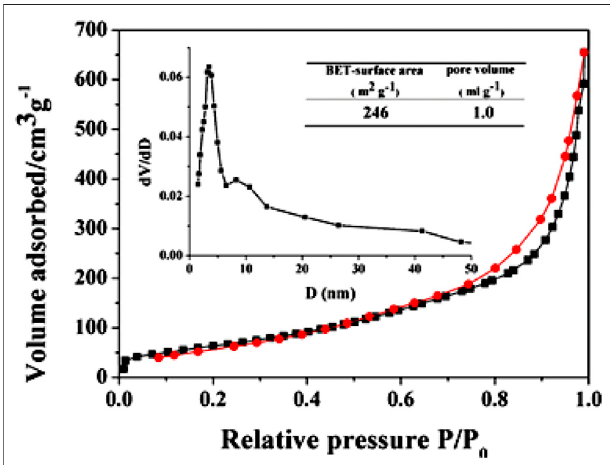
FIGURE 5 | Adsorption – desorption isotherms of the representative the porous TiO 2 microspheres. Inset shows the pore size distribution obtained from the adsorption